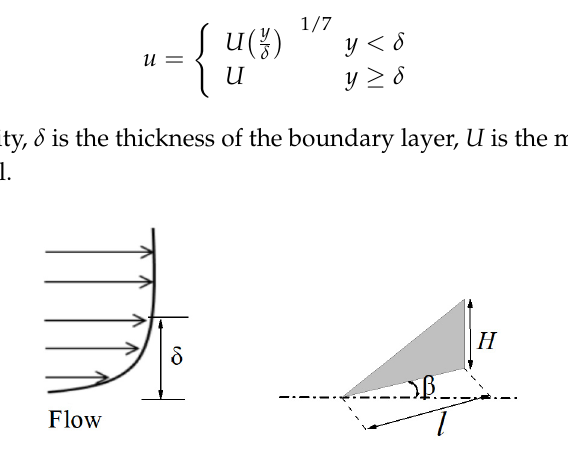
Table 1. VG geometric parameters.